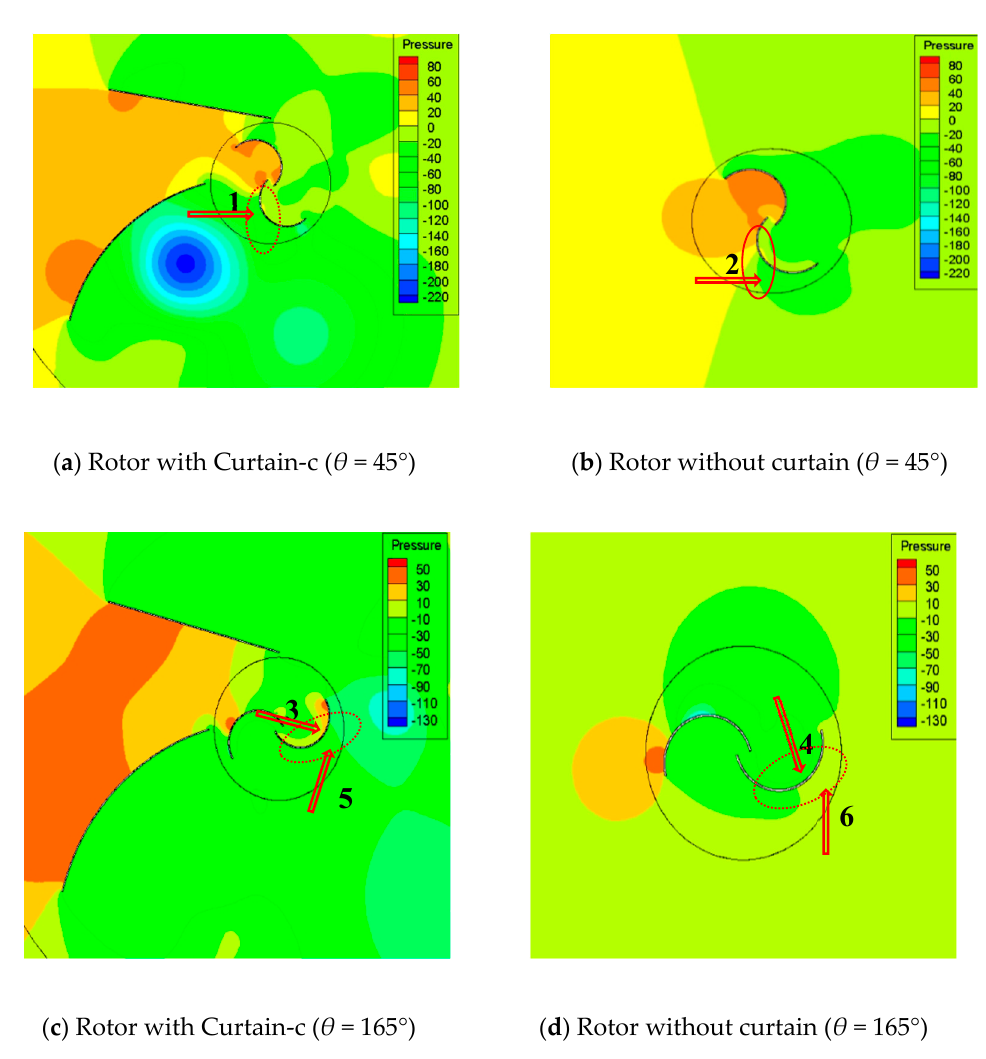
Figure 19. Pressure contours of the wind rotor with Curtain-c at ( a ) θ = 45°, ( c ) θ = 45°and without Curtain-c at ( b ) θ = 165°, ( d ) θ = 165°.